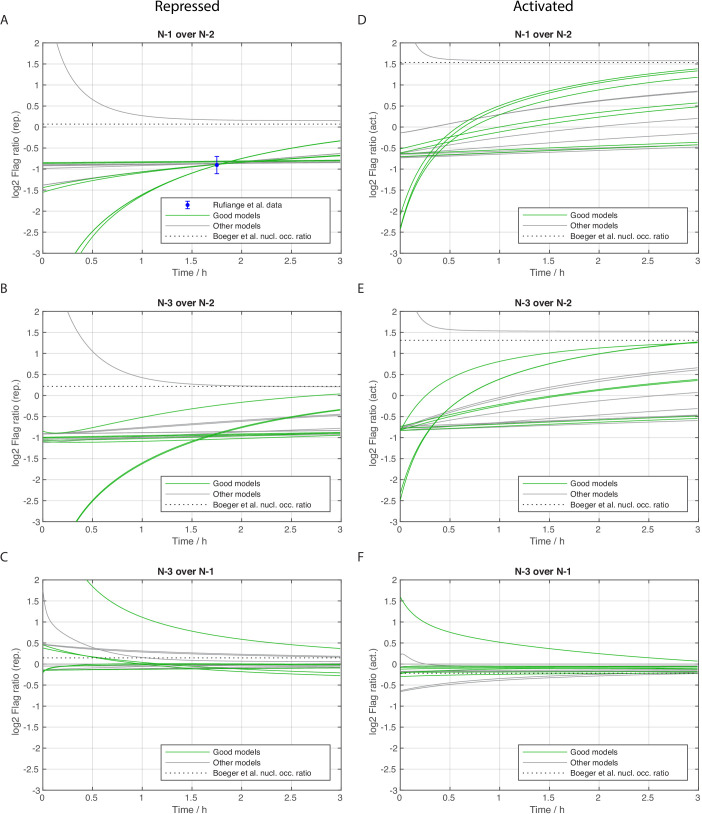
Stage 3: Flag amount ratios of tested models.Dynamics of Flag amount ratios after Flag expression (shifted by 0.25 h lag time) of different sites for repressed (left column) and activated state (right column), calculated for all models with satisfactory likelihood after stage 2. Green lines represent the satisfactory models of stage 3. The dashed lines show the steady state ratio that eventually all models should reach closely. (A) Ratio of N-1 over N-2 in repressed state with available experimental data. The three groups of green lines match the three model groups of the main text and Figure 4: almost constant lines (group 3), slightly rising lines (group 1), and quickly rising lines (group 2). (B) As panel A but for the ratio of N-3 over N-2 and without experimental data. (C) As panel B, but N-3 over N-1. (D, E, F) All three ratios now for the activated promoter state.